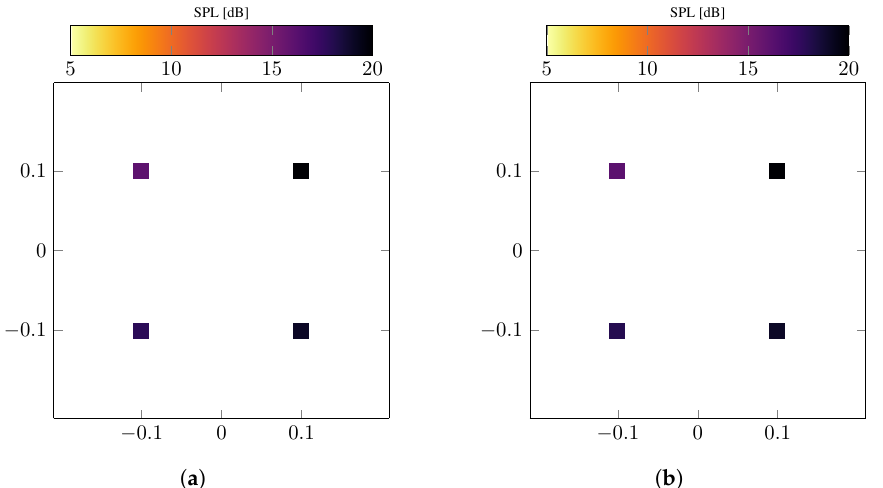
Figure 2. Reference solutions for numerical example. ( a ) Exact solution; ( b ) FISTA solution with exact phase